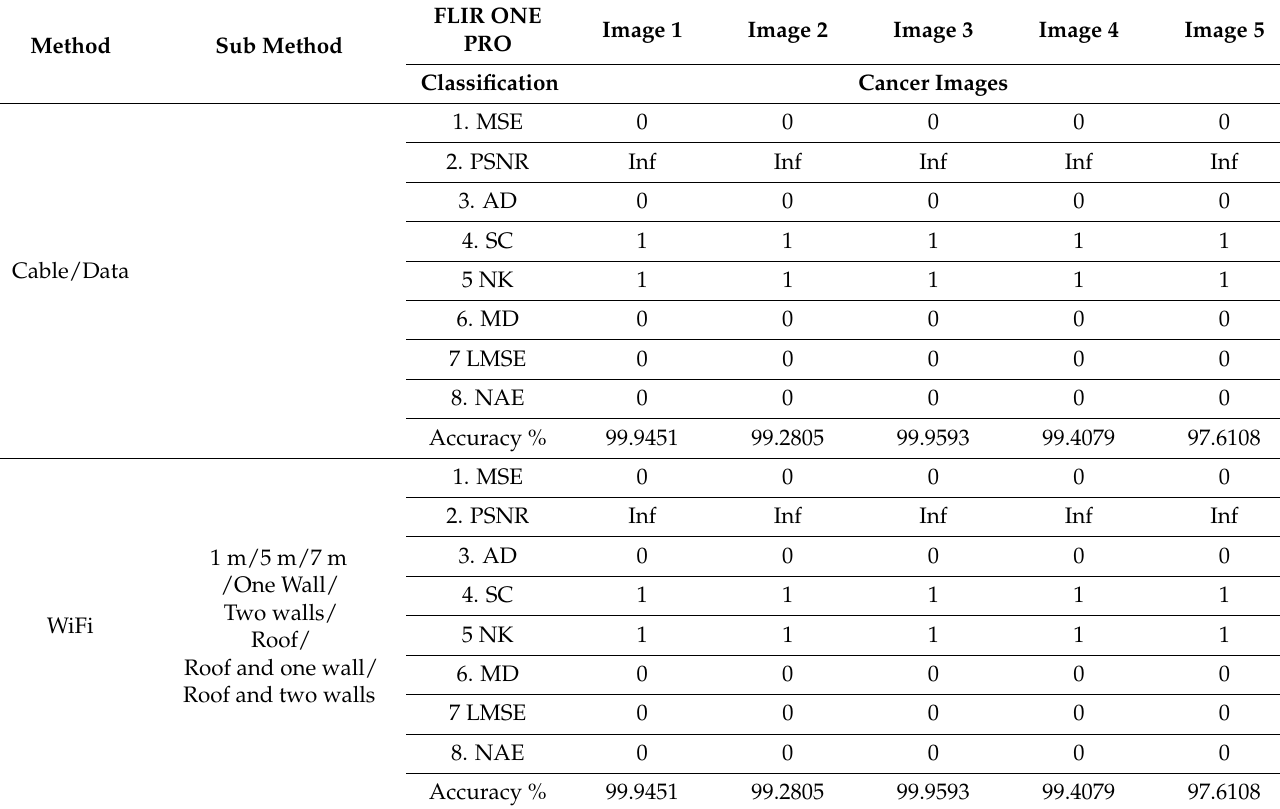
Table 3. Detection accuracy and quality of thermal images (FLIR one PRO) after